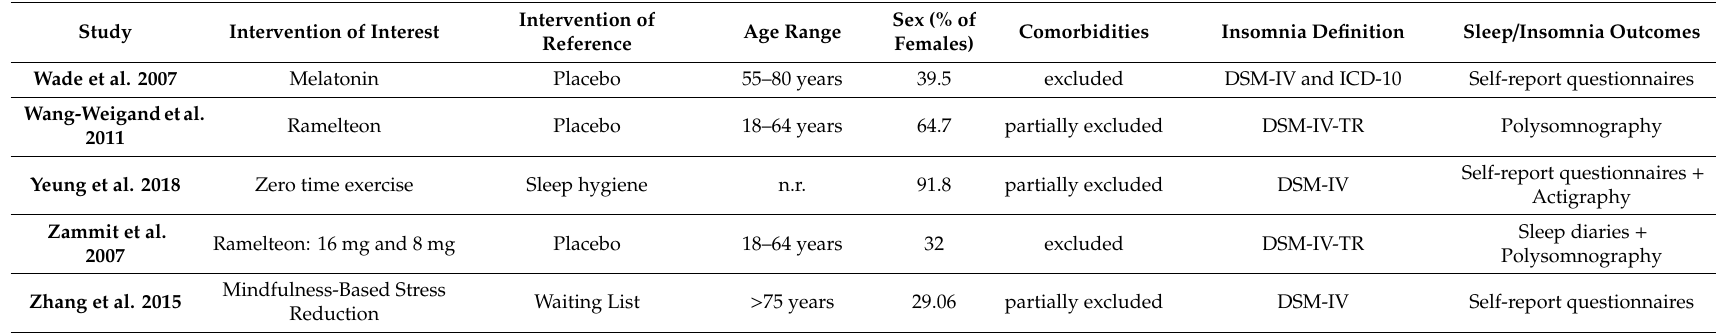
Legend to Table 1: Legend: rTMS, repetitive transcranial magnetic stimulation; CBT-I, Cognitive Behavioral Therapy for Insomnia; n.r., not reported; GAD, Generalized Anxiety Disorder; DSM, Diagnostic and Statistical Manual of Mental Disorders; ICSD, International Classification of Sleep Disorders; SOL, Sleep Onset Latency; WASO, Wake After Sleep Onset; ICD, International Classification of Diseases; TST, Total Sleep Time; SEI, Sleep E ffi ciency Index; SD, Standard Deviation; MBSR, Mindfulness-Based Stress Reduction; MBTI, Mindfulness-Based Therapy for Insomnia; MAE, Moderate-intensity aerobic exercise; HAE, High intensity aerobic exercise; MRE, Moderate intensity resistance exercise; SHS, Sleep hygiene